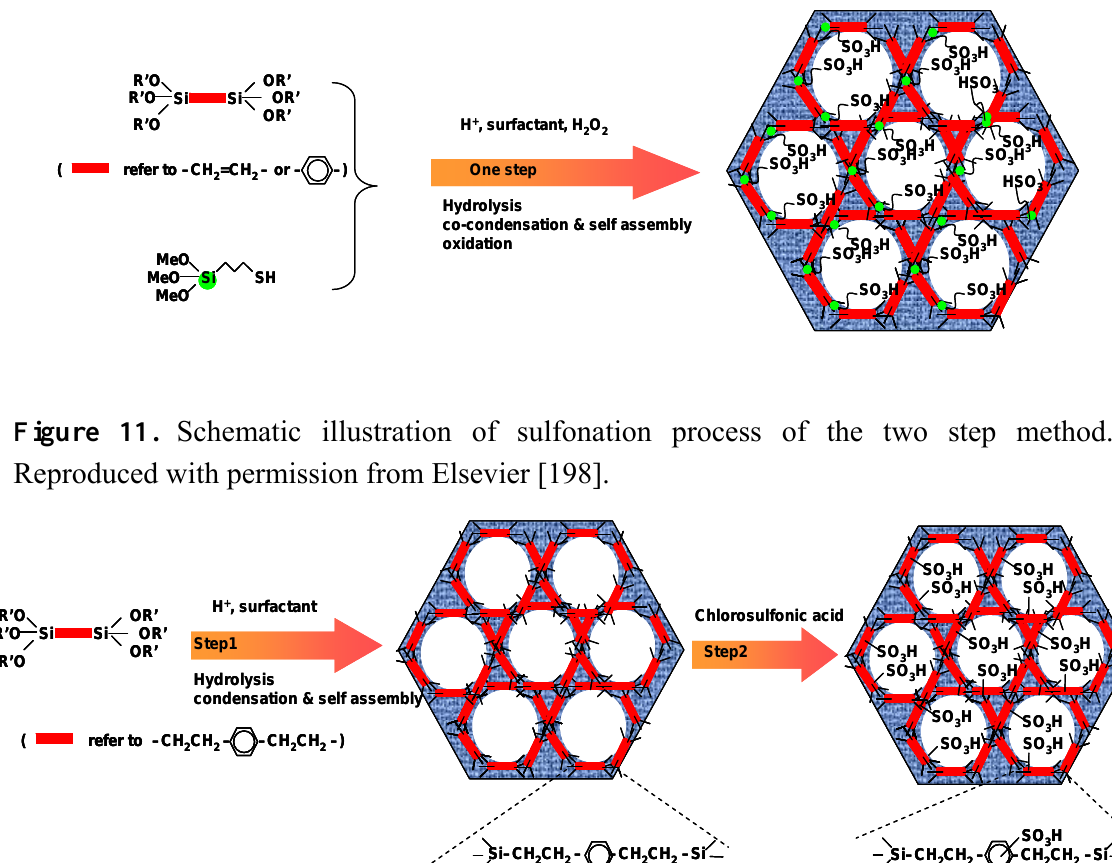
Figure 10. Direct synthesis of sulfonic acid-functionalized mesoporous organosilicas. Reproduced with permission from Elsevier [197].